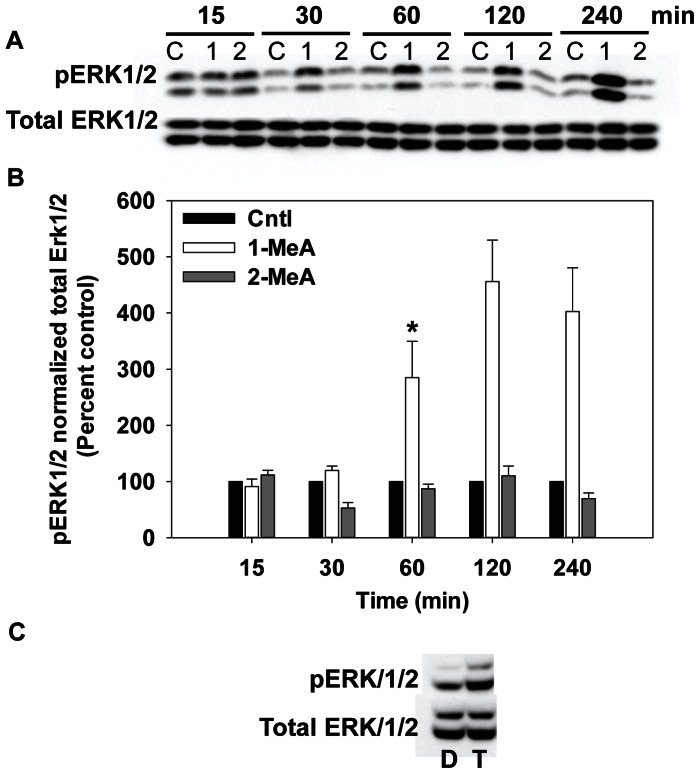
Phospho-ERK1/2 MAPK activation following treatment with 1- but not 2- MeA.(A) Immunoblot for pERK1/2 and total ERK for 15 min to 4 h of treatment. (B) Densitometric analysis of pERK1/2 normalized to total ERK, represented as percent control. Concentrations used: 75 µM 1-MeA and 75 µM 2-MeA. Mean ± SEM presented with n = 3 per study, replicated 3 times. 1-MeA, 1-methylanthracene; 2-MeA, 2-methylanthracene; Cntl, CH3CN vehicle control. *p<0.05 compared to control; +p<0.05 compared to 2-MeA treated cells at the same time point. (C) Positive control using T, TPA (50 nM, 60 min) or D, DMSO (negative control) for activation of ERK1/2.